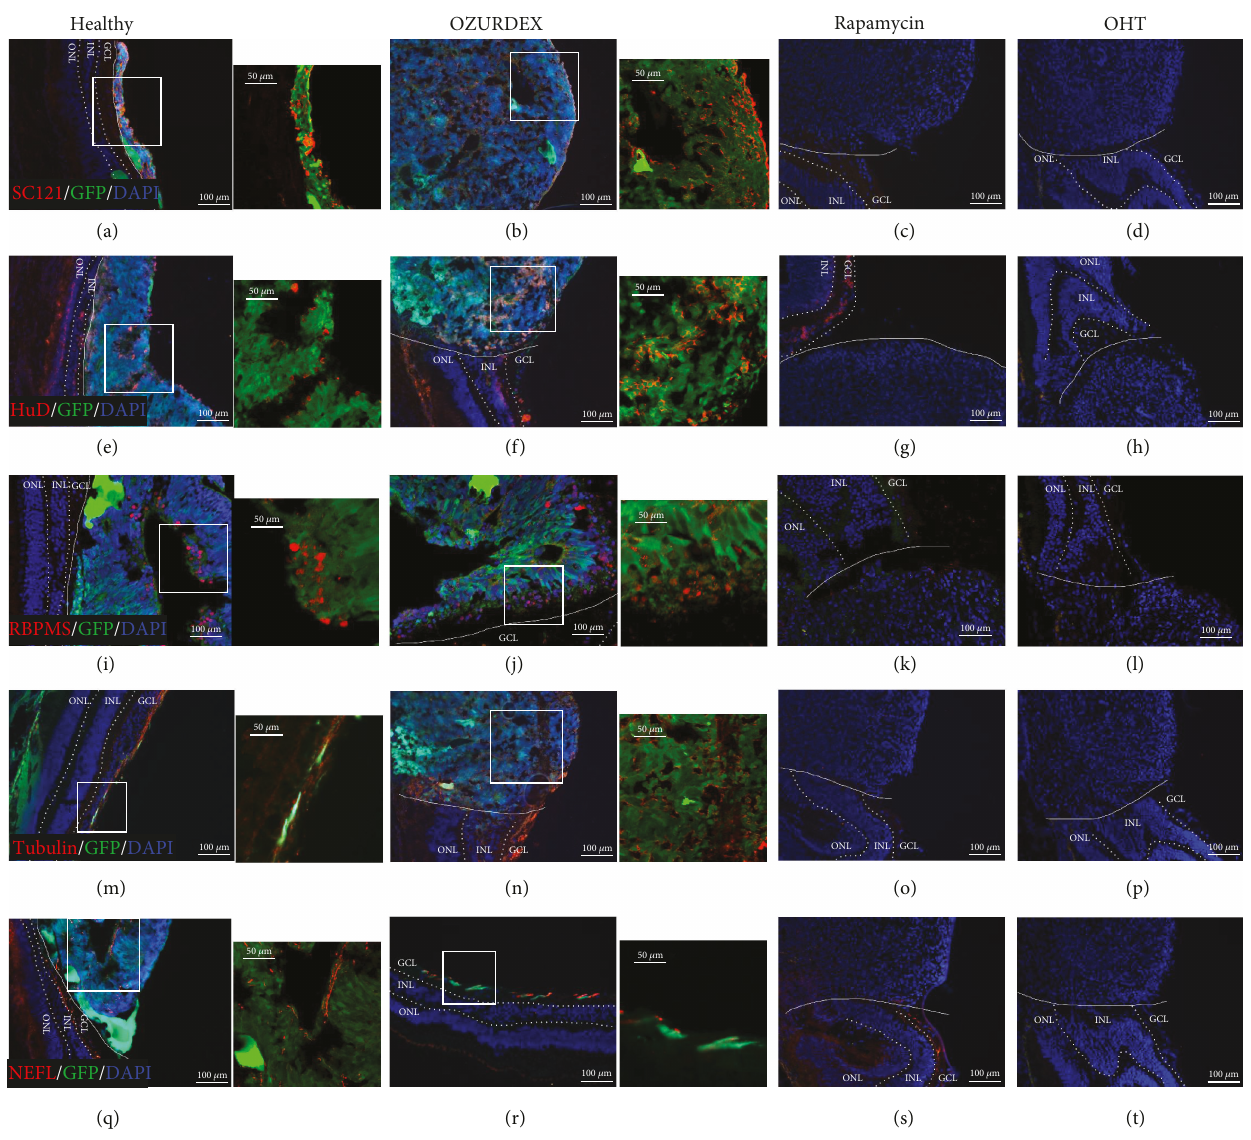
Figure 6: Survival and di ff erentiation of retinal organoid cells as analyzed by immuno fl uorescence microscopy after transplantation. (a, b) The SC121-positive cells expressing green fl uorescent protein (GFP), which were used for construction of the retinal organoids, were clearly visible in the healthy eye (transplanted with a retinal organoid, but receiving no immunosuppressive treatment) and the Oz-eye (eye with ocular hypertension (OHT) transplanted with a retinal organoid and treated with dexamethasone), indicating that cells from the transplanted organoids were alive in the host retina. However, in (c) the RAP-eye (OHT eye transplanted with a retinal organoid and treated with rapamycin) and (d) the OHT-eye (OHT eye transplanted with a retinal organoid, but receiving no immunosuppressive treatment), no SC121-positive or GFP-positive cells were detected. HuD- and RBPMS-positive retinal ganglion cells (RGCs) were also observed in (e, i) the healthy eye and (f, j) the Oz-eye. (m) Tubulin- and (q) NEFL-positive axons were observed within and near the transplants in the healthy eye. (n) Tubulin- and (r) NEFL-positive axons were observed within and near the transplants in the Oz-eye. In (c, g, k, o, s) the RAP-eye and (d, h, l, p, t) the OHT-eye, no cells or axons expressing these markers were detected. GCL: ganglion cell layer; INL: inner nuclear layer; ONL: outer nuclear